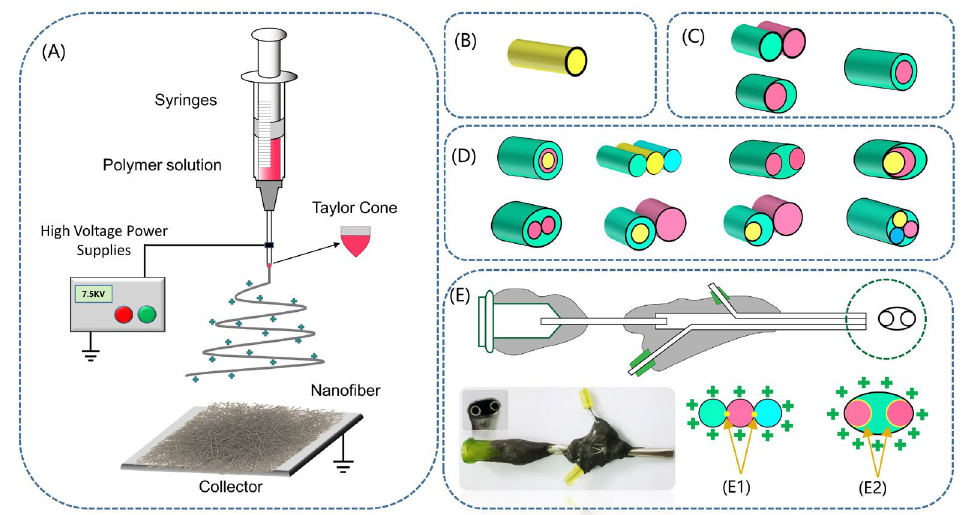
Figure 4. ( A ) Schematic diagram of electrospinning equipment. ( B ) Single-fluid electrospun tech- nology. ( C ) Double-fluid side-by-side and coaxial electrospun. ( D ) Tri-fluid coaxial and tri-layer side-by-side and special structures electrospun technology. ( E ) Tri-layer side-by-side electrospinning needle schematic and realistic pictures.